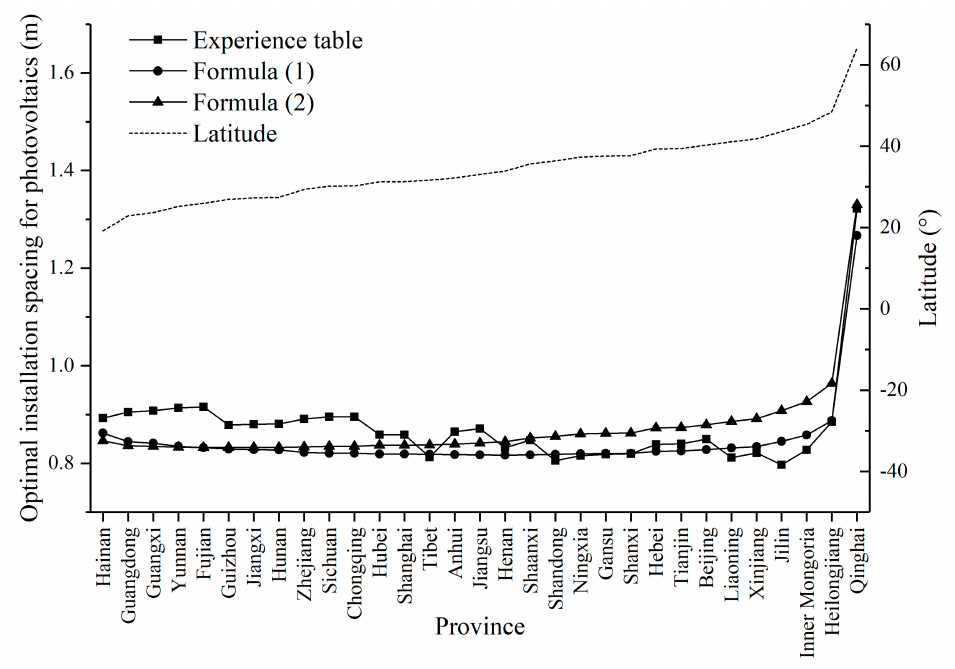
Figure 8. Comparison of the best installation spacing in various provinces and